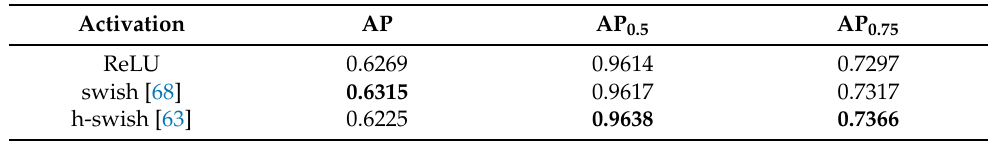
Table 4. Comparisons of various activation functions in SIA